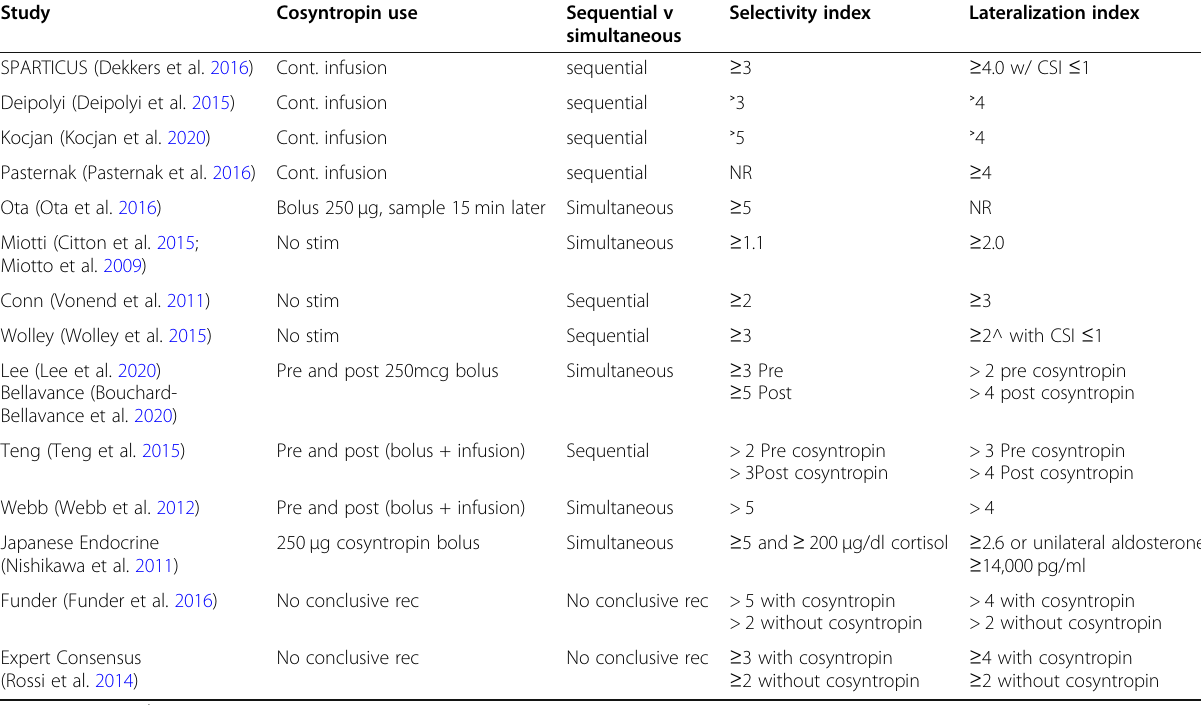
Table 5 Marked heterogeneity of basic procedural aspects of